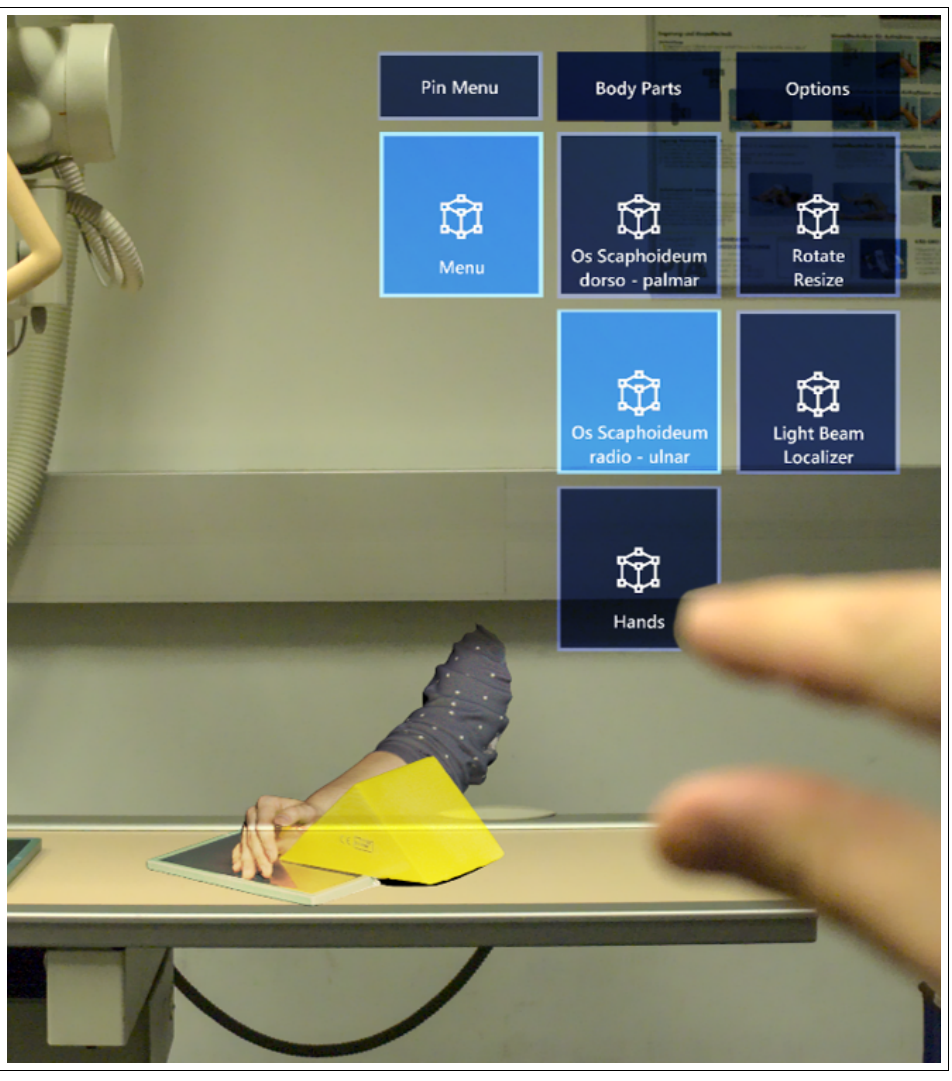
Figure 6. User interaction with ARTUR from the user’s